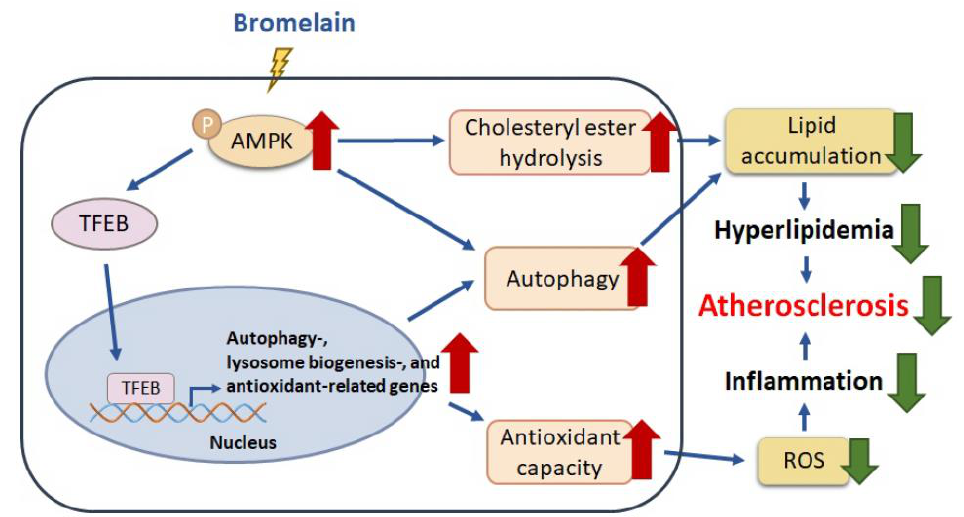
Figure 9. The proposed molecular mechanisms by which bromelain activates TFEB to reduce lipid accumulation, oxidative stress, and inflammation and also to retard atherosclerosis progression. Bromelain induces TFEB activation, which upregulates the expression of autophagy- and antioxidant-related proteins and alleviates lipid accumulation, oxidative stress and inflammation, leading to the retardation of atherosclerotic progression in apoe −/− mice.